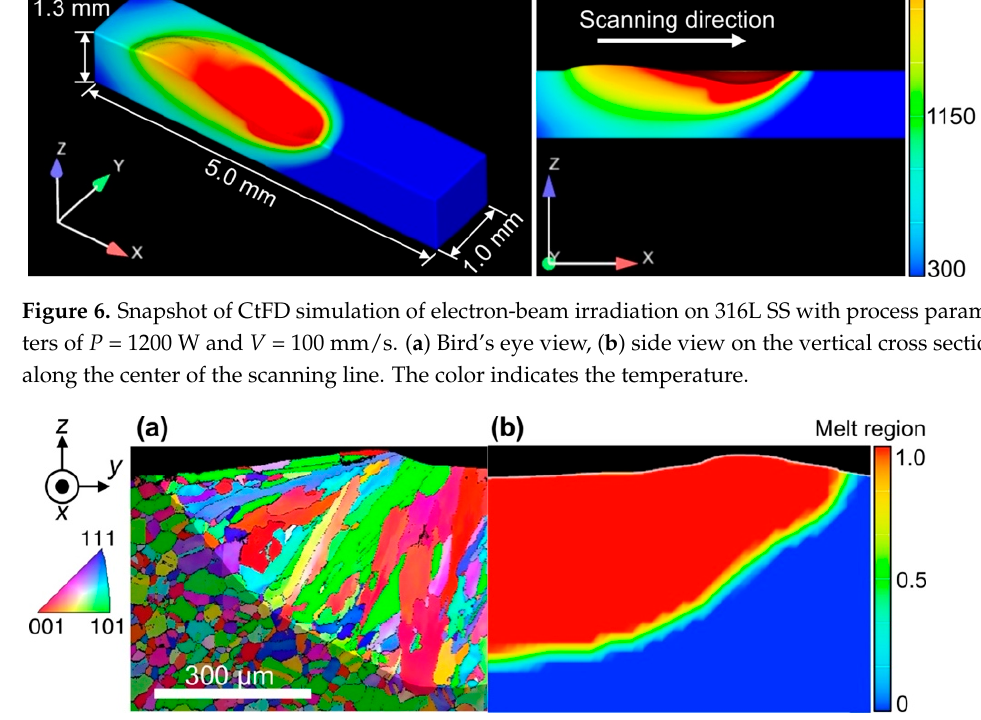
Figure 7. Comparison of melt regions in ( a ) experimental SEM image and ( b ) CtFD simulation for the case with a beam diameter of 1200 μ m, absorption rates of 0.8, beam power ( P ) of 1200 W, and the case with a beam diameter of 1200 µ m, absorption rates of 0.8, beam power ( P ) of 1200 W, and beam scanning speed ( V ) of 100 mm/s. beam scanning speed ( V ) of 100